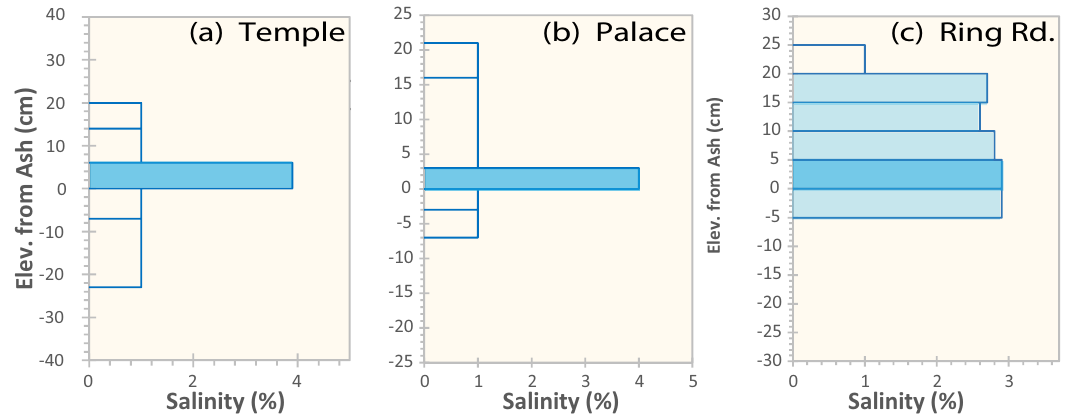
Figure 48. Salinity in TeH Sediment. Percentage of salinity for 3 sites, temple, palace, and ring road. The wadi site had < 1% salt content in all samples. Open bars mean below detection (<